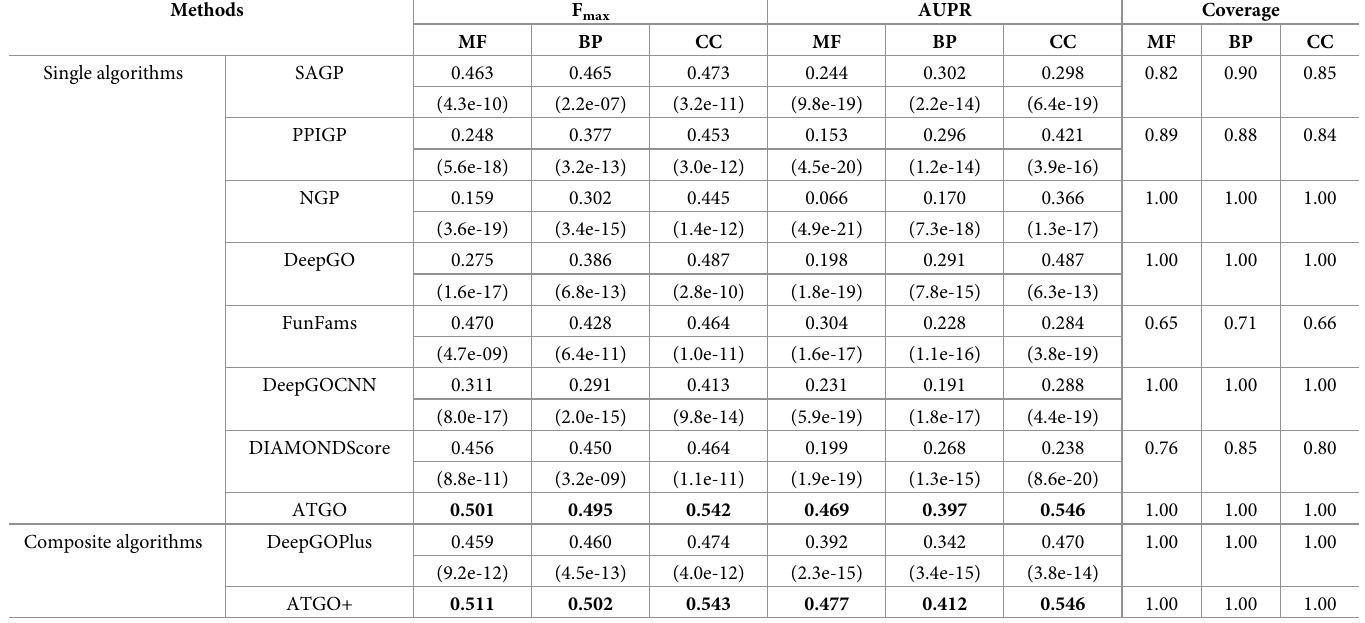
Table 2. Comparison of ATGO/ATGO+ with other 8 competing methods on 3328 CAFA3 targets where a sequence identity cut-off t 1 = 30% between the training and testing proteins was applied to the five in-house methods (ATGO, ATGO+, SAGP, PPIGP, and NGP). p -values in parenthesis are calculated between ATGO and other single-based methods and between ATGO+ and other composite methods by two-sided Student’s t-test. Specifically, the proposed ATGO and ATGO+ are repeatedly implemented with 10 times on the benchmark dataset to generate the corresponding performance evaluation indices, which are compared with the fixed evaluation index generated by the competing method to calculate p -value using two-sided Student’s t-test. Bold fonts highlight the best performer in each category. Coverage is the ratio of the number of proteins with available prediction scores divided by the total number of test proteins.